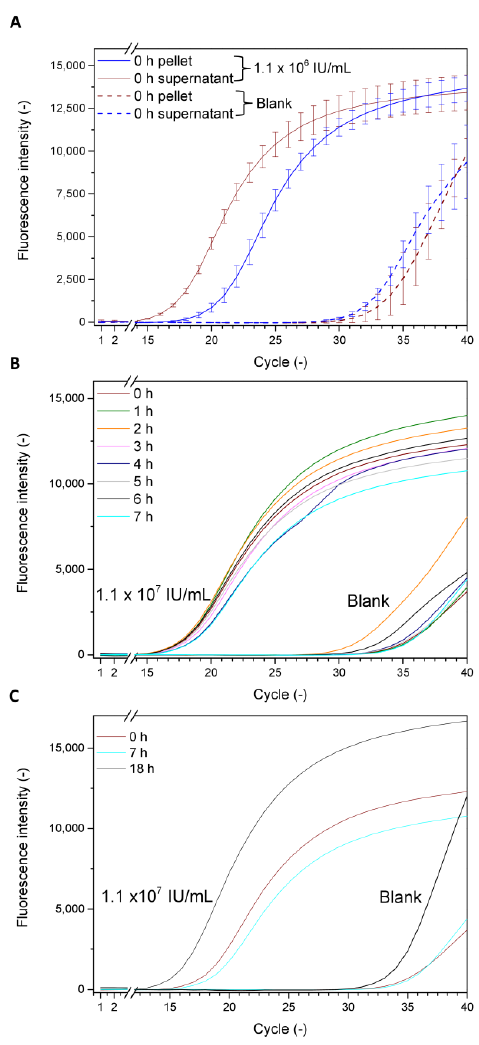
Figure 2. Amplification plots of the baculovirus DNA by qPCR measurements. The DNA was extracted from samples taken either from the supernatant or from the cell pellet of infected cells after 5 min (i.e., 0 h) of incubation and compared to a negative control ( A ). The amount of viral DNA detectable in the cell pellet was monitored over the course of 7 h ( B ) and compared to values after 18 h of infection ( C ). All samples were prepared in triplicates, with error bars only being displayed in ( A ) to allow a clearer view of the data.